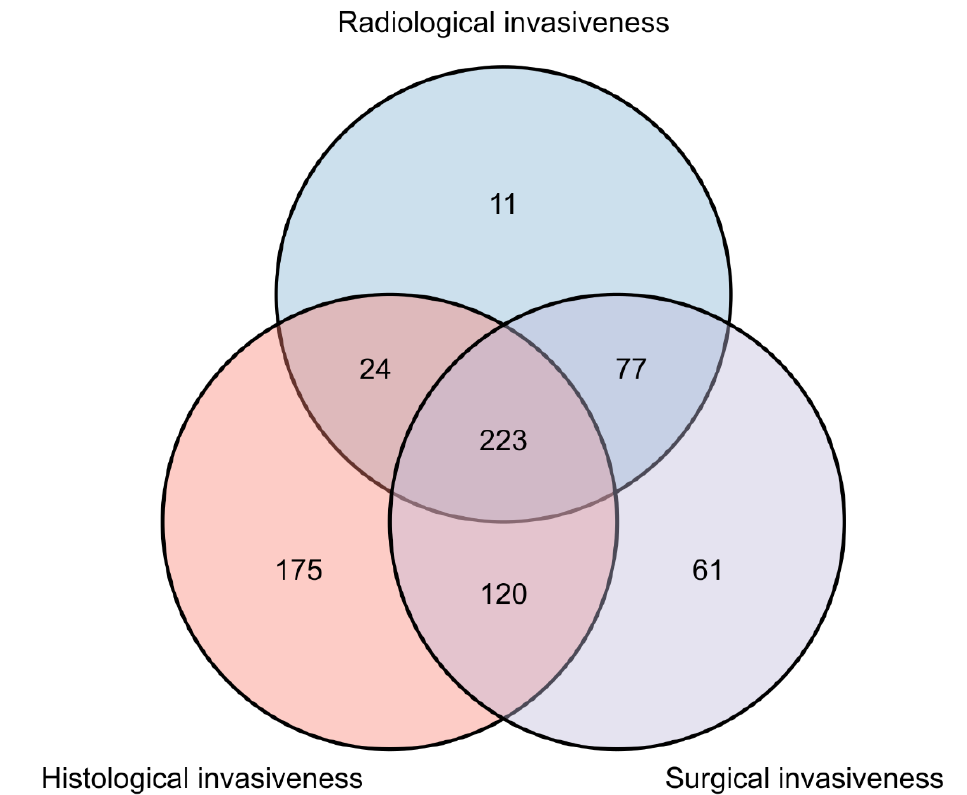
Figure 2. Venn chart illustrating the number and interactive information of patients with radiological, surgical, and histological invasiveness. surgical, and histological